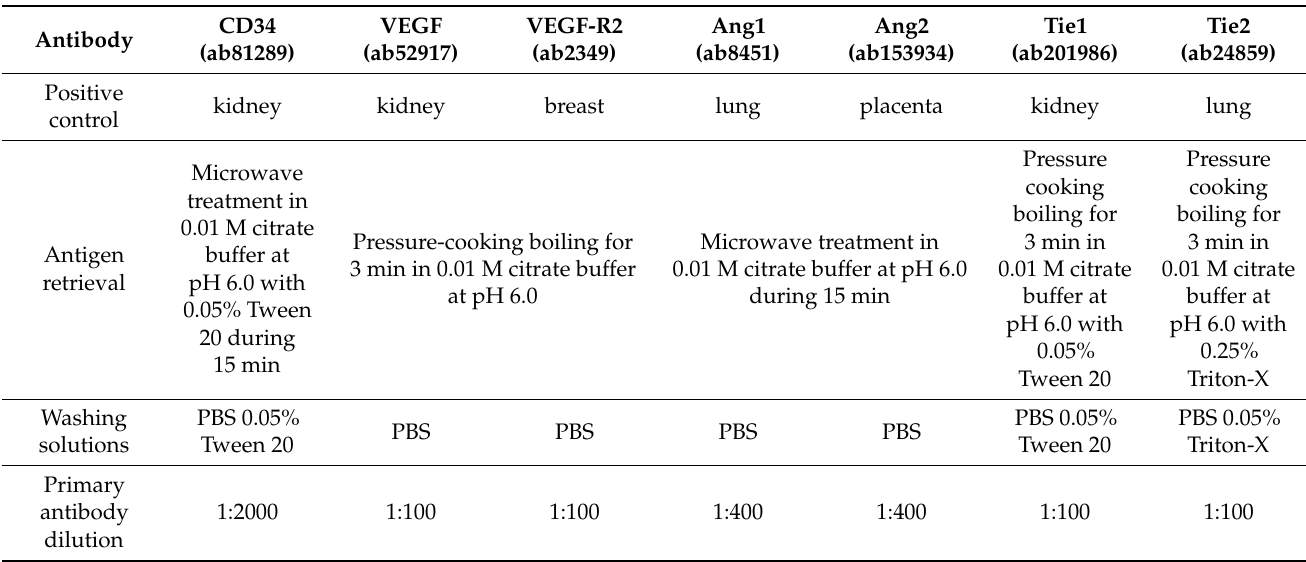
Table 5. Summary table of positive control, antigen retrieval, washing solution and dilution for each antibody